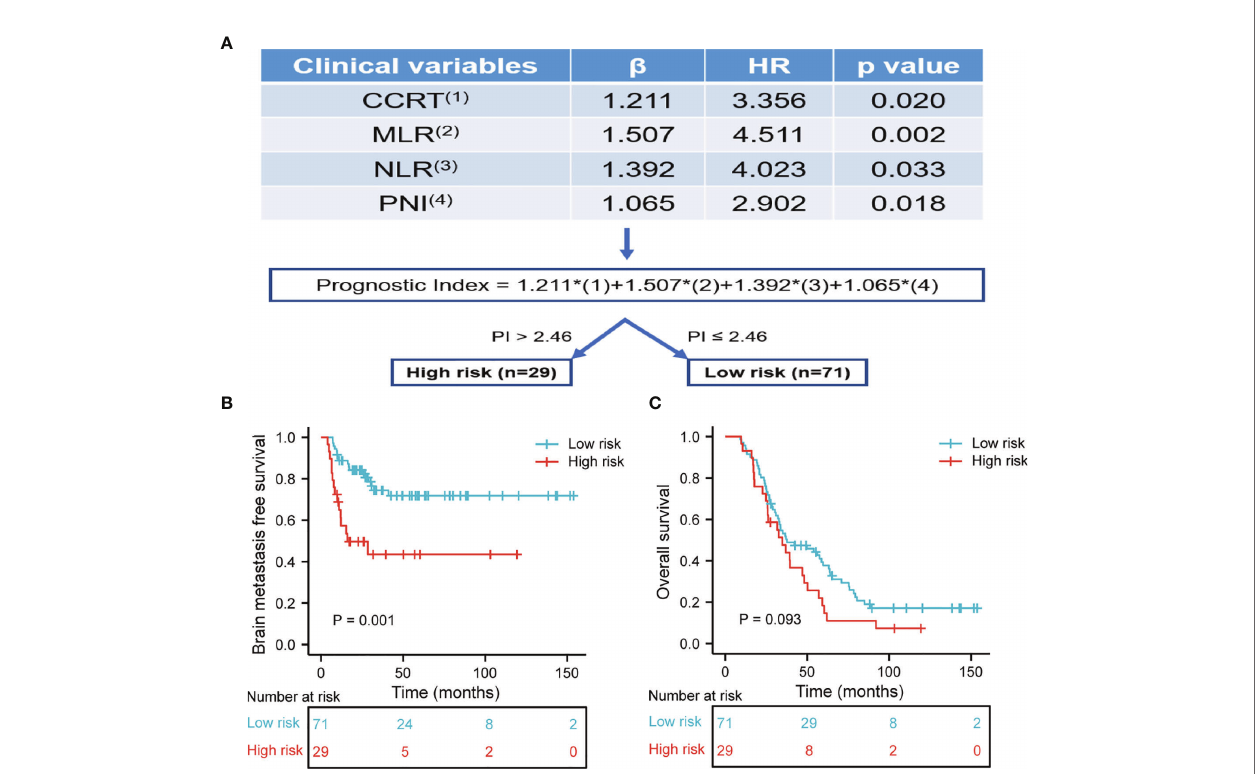
FIGURE 3 | (A) The risk prediction model of BM. The prognostic index for predicting BMFS was calculated by multiplying the weighted factor ( b coef fi cient) with four statistically signi fi cant variables. Each factor is one for existence and zero in the absence. The prognostic index was divided into high-risk and low-risk subset with a boundary of 2.46. (B) Brain metastasis free survival was risk strati fi cation according to prognostic index. The high-risk group had poor BMFS than the low-risk group (p = 0.001). (C) Overall survival was risk strati fi cation according to prognostic index. The high-risk group had poor OS than the low-risk group, but it was not statistically signi fi cant (p = 0.093).